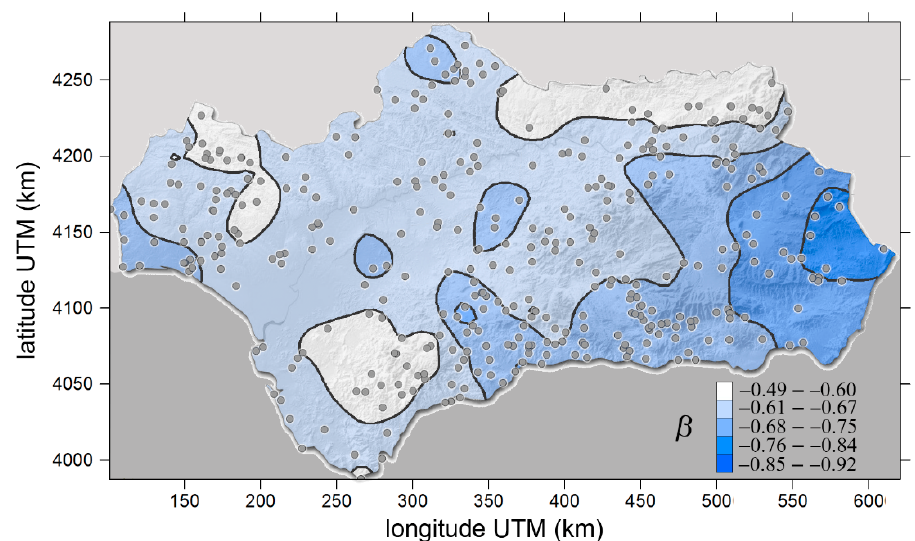
Figure 7. Representation of the scaling parameter 𝛽 vs. ( a ) the CDD drought index and ( b ) the CWD index.